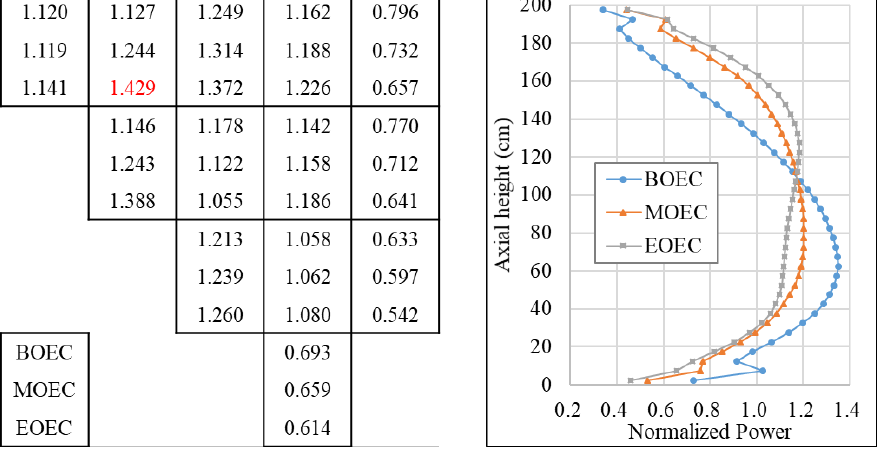
Figure 5: Radial and Axial Power Profile of The ATOM core with SS-304